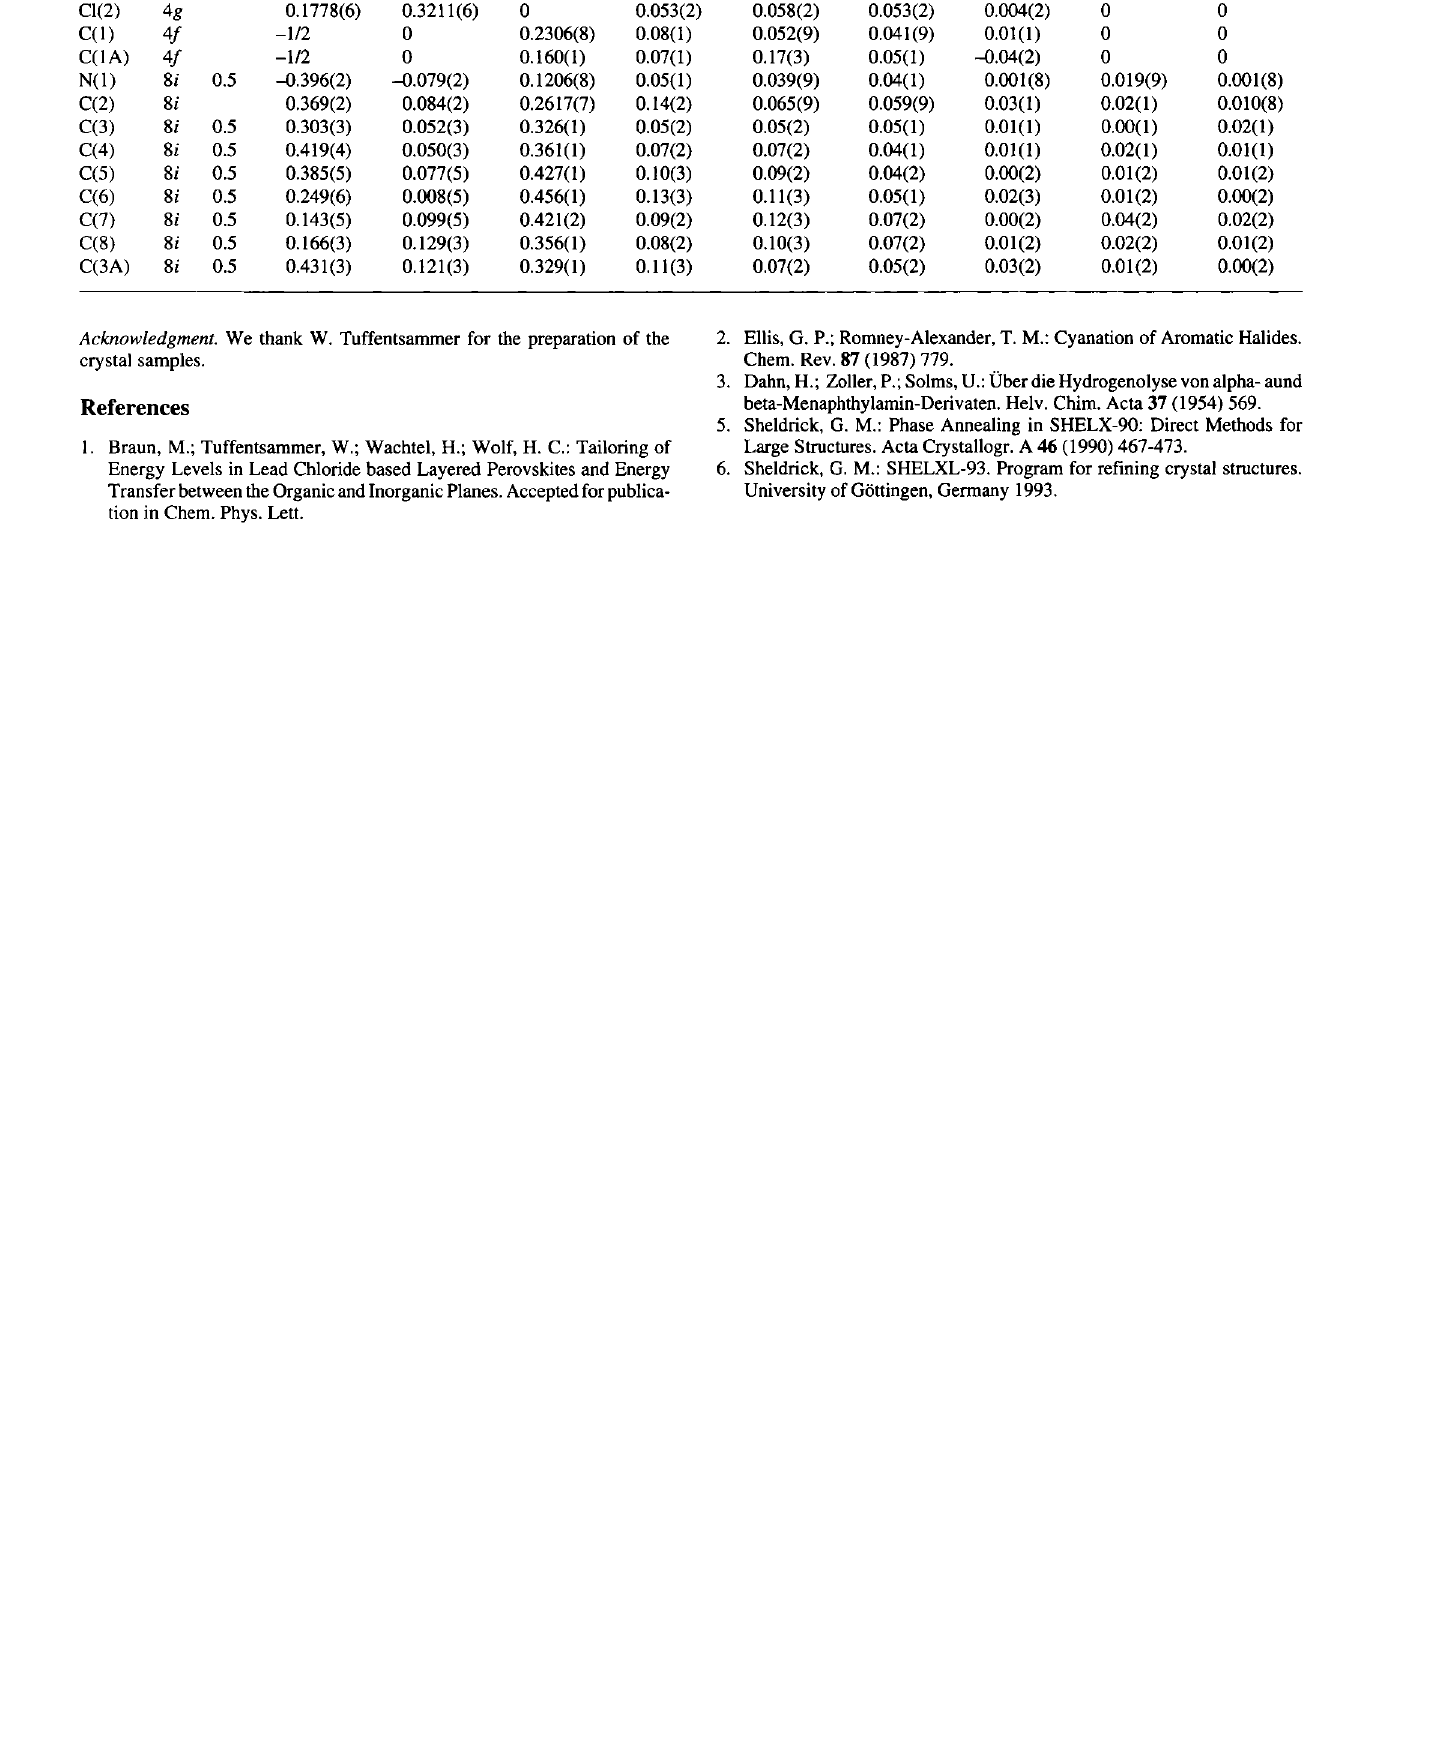
Table 3. Atomic coordinates and displacement parameters (in Â 2 ). Atom Site